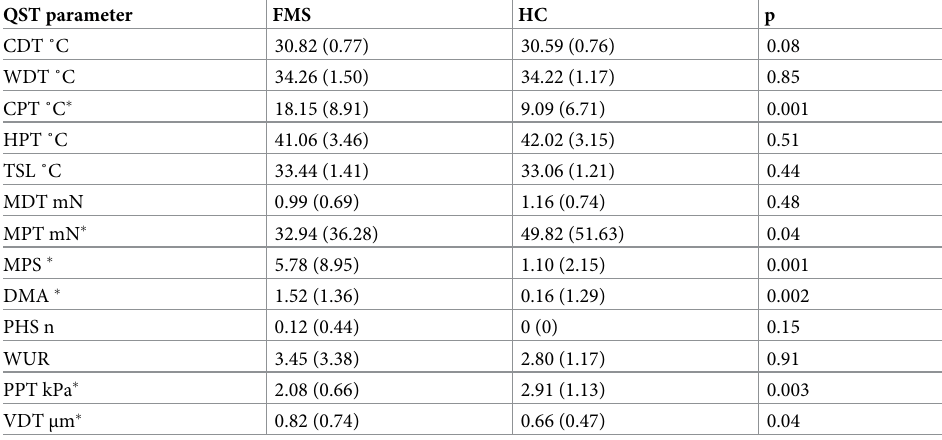
The values shown are means, with SD given in parenthesis; � indicates a significant p-value, ANOVA was used as a statistical test.